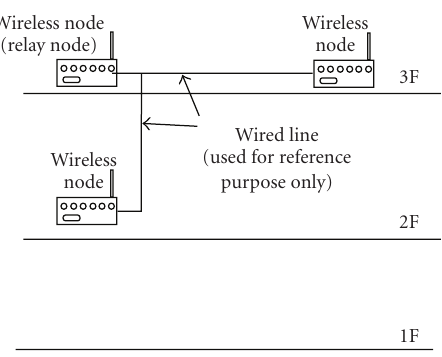
Figure 11: Allocation of wireless node.